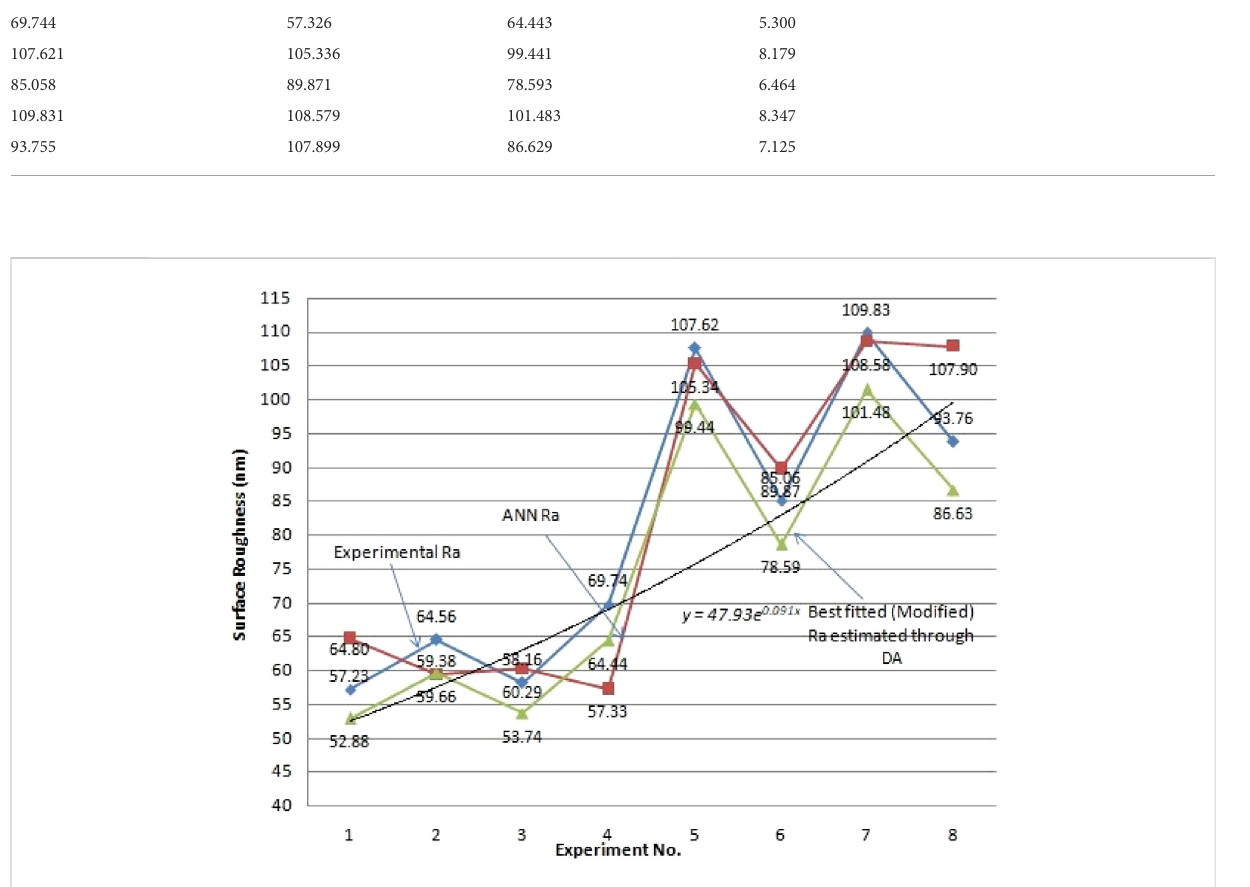
FIGURE 4 Comparison of experimental, ANN, and modi fi ed